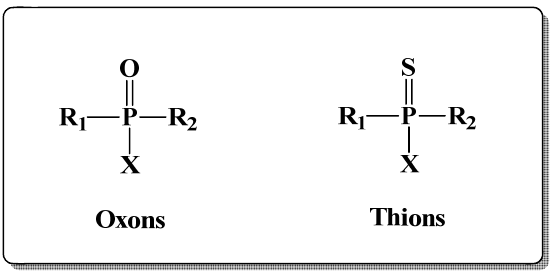
Figure 1. General chemical structure of oxon and thion OP